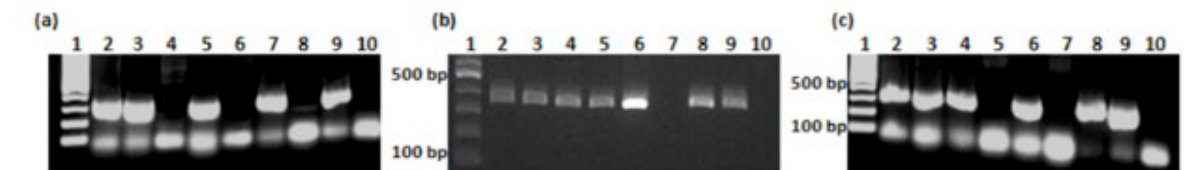
Figure 2. Electropherogram of RT-PCR reactions conducted on several progeny explants generated from tissue culture and thermotherapy techniques. (a): Agarose gel showing healthy (lanes 4, 6, 8) and FLMaV-1-infected explants (lanes 2, 3, 5, 7). (b) Agarose gel showing healthy (lane 7) and FLMaV-2-infected samples (lanes 2-6, 8). (c) Agarose gel showing healthy (lanes 5, 7) and FMV-infected samples (lanes 2-4, 6, 8). Lanes 9 and 10 represent RT-PCR positive and negative controls, respectively, for each